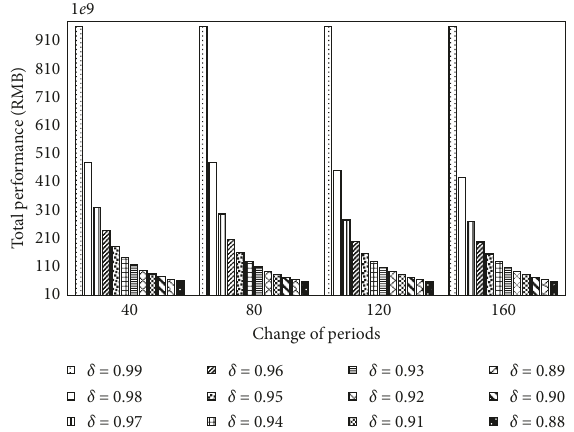
Figure 12: Total performance under the different discount factors and planning